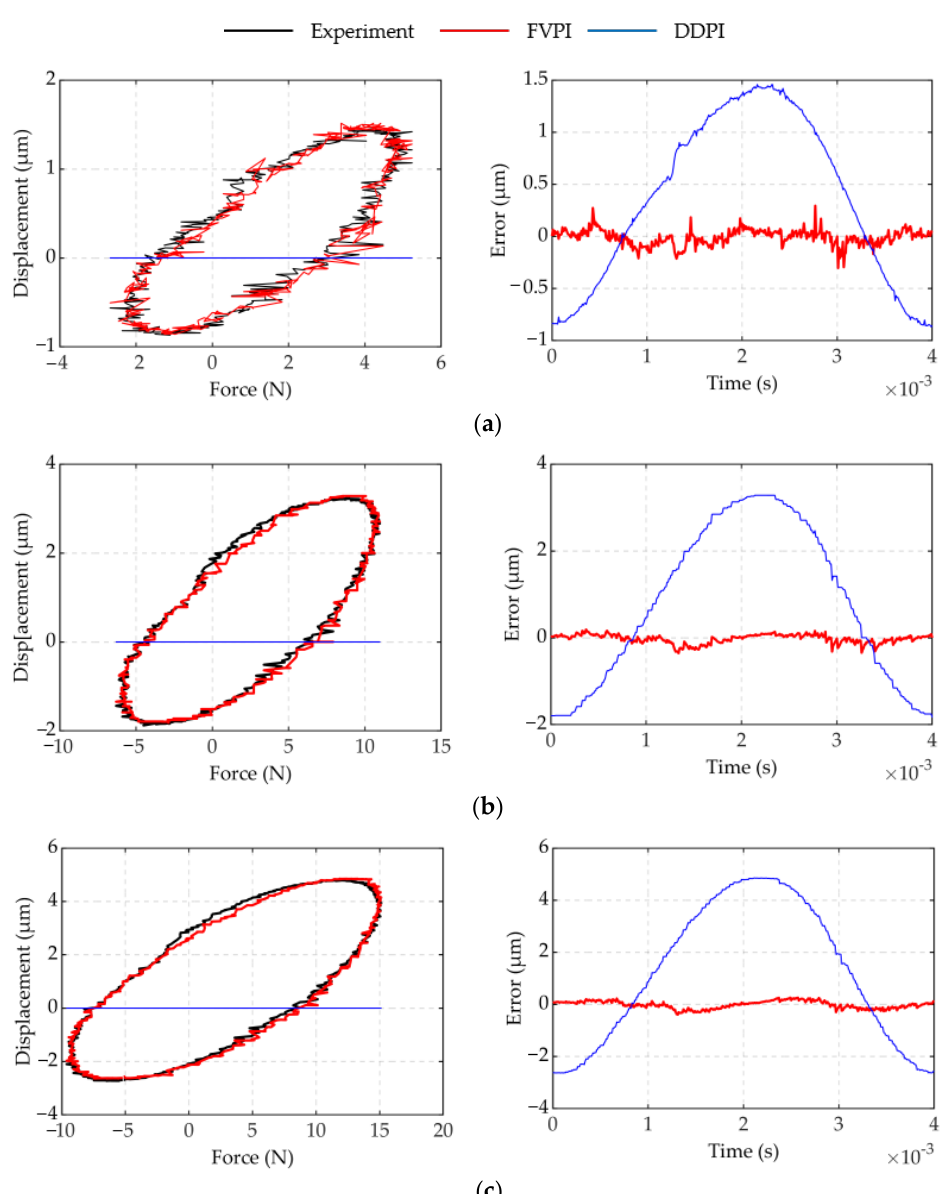
Figure 15. The FVPI model and experimental data at 250 Hz under different forces: ( a ) spring 2; ( b ) spring 3; ( c ) spring 4.